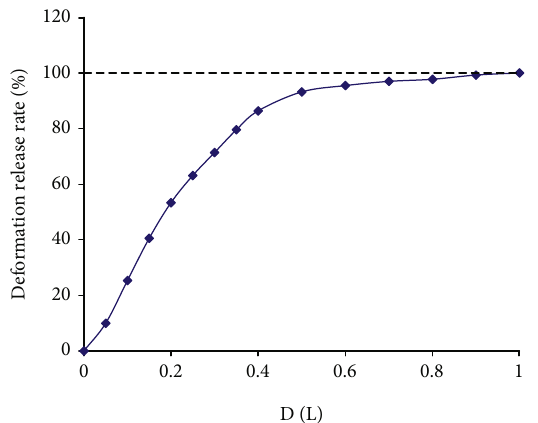
Figure 7: Relation between the slot ’ s depth-to-length ratio ( D / L ) and its deformation release